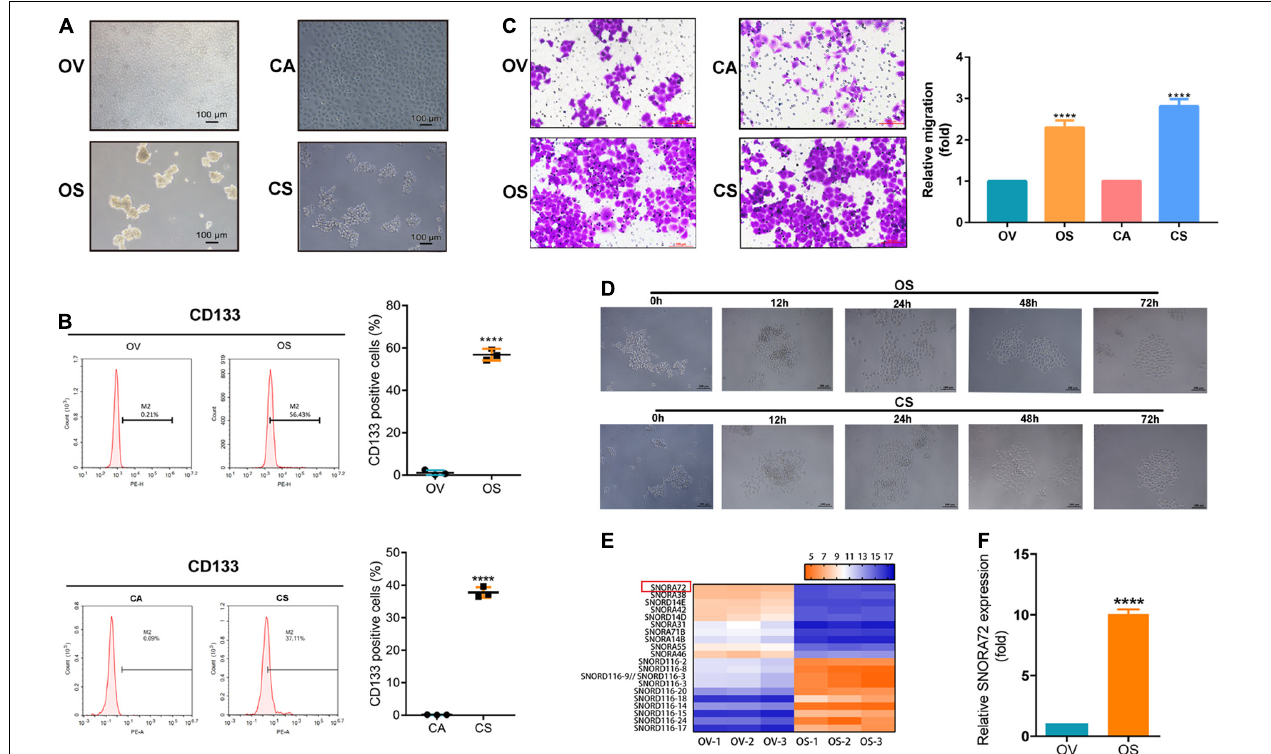
FIGURE 1 | SNORA72 is overexpressed in ovarian cancer stems cells (OCSCs). (A) Morphology of OVCAR-3 (OV), OVCAR-3 spheroid (OS), CAOV-3 (CA), and CAOV-3 spheroid (CS) cells shown under a microscope ( × 10). (B) Expression of CD133 detected by flow cytometry in OV vs OS and in CA vs CS cells. (C) Migration abilities of OV, OS, CA, and CS cells by Transwell assay. (D) Differentiation morphology of OS and CS cells at 0, 12, 24, 48, and 72 h. (E) Hierarchical clustering analysis of small nucleolar RNA (snoRNA) expression from non-coding RNA-ChIP data in OV and OS cells. Red , higher expression levels; green , lower expression levels. (F) Relative SNORA72 expression to U6, as an endogenous control, analyzed by qRT-PCR in OV and OS cells. The SNORA72 expression in OV cells was set as 1. Data are shown as the mean ± SD from three independent experiments. ** P < 0.01, **** P < 0.0001.